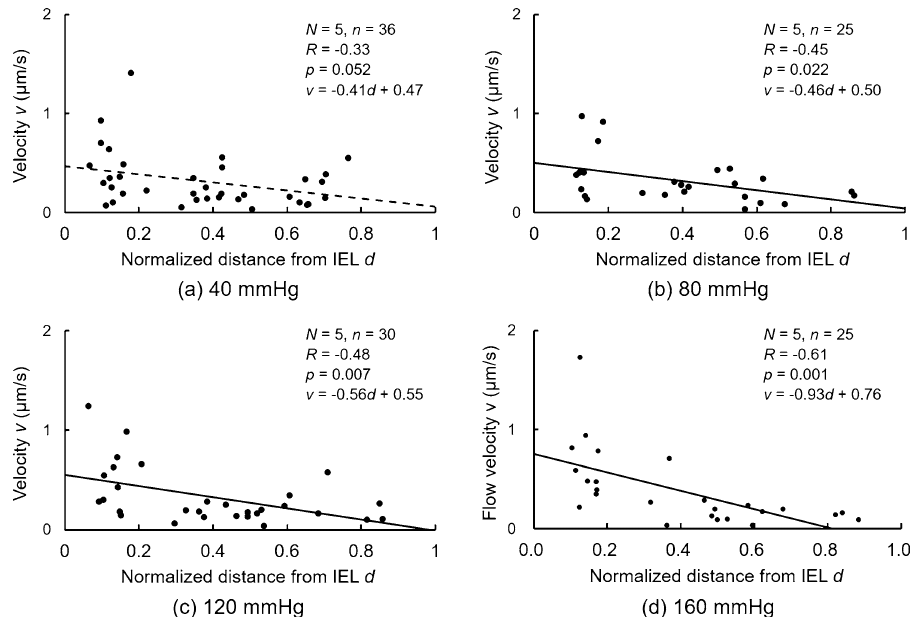
Figure 7. Correlations between normalized distance d from the IEL and interstitial flow velocity v at intraluminal pressure P of ( a ) 40, ( b ) 80, ( c ) 120, and ( d ) 160 mmHg. N , number of mice; n , number of data ; R , correlation coefficient. The correlation coefficient R was tested using the Student’s t -test. The graph was created using the Microsoft Excel for Microsoft 365 MSO (16.0.14326.20782).